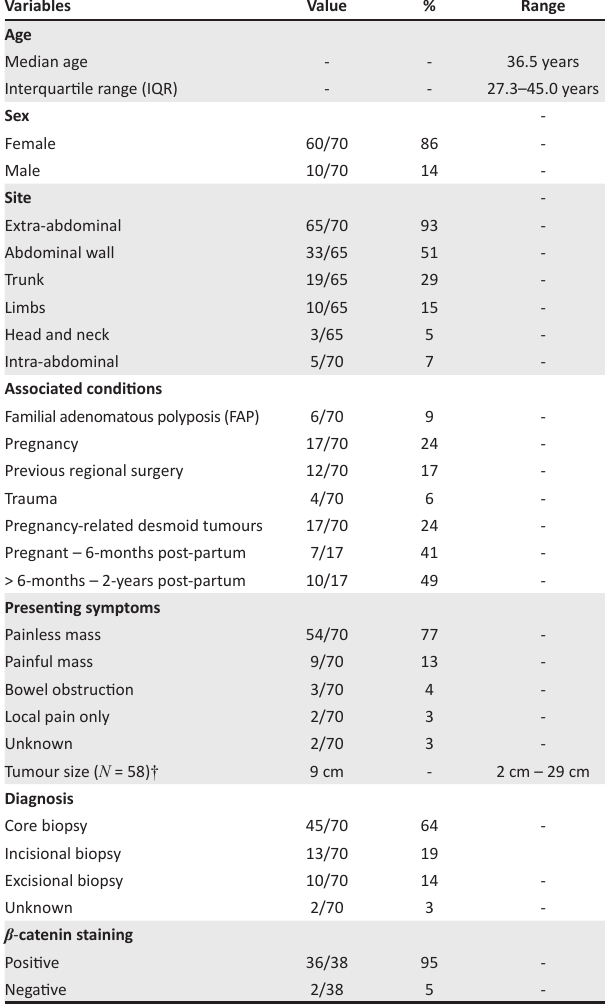
† , Combination of clinical, imaging and operative specimen